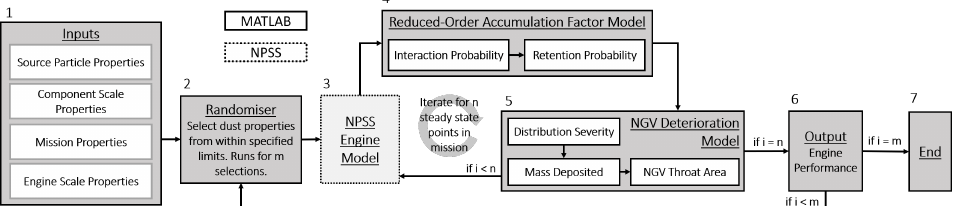
Figure 4. Block diagram showing the structure of the coupled degradation model used to carry out the statistical analysis of dust properties for dust cloud encounter events. Step numbers in the model process are indicated above each